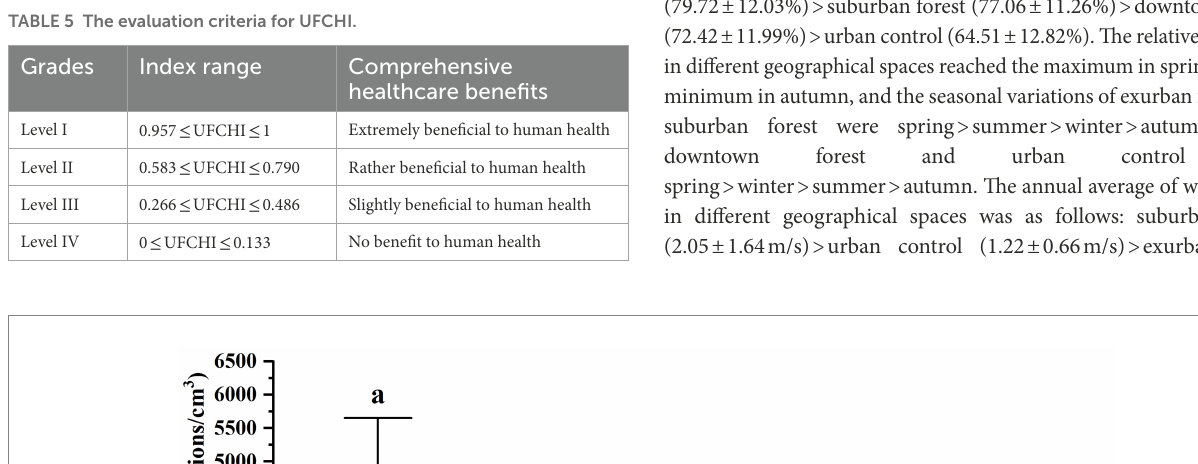
FIGURE 2 Cluster analysis using Ward’s method and squared Euclidean distance.